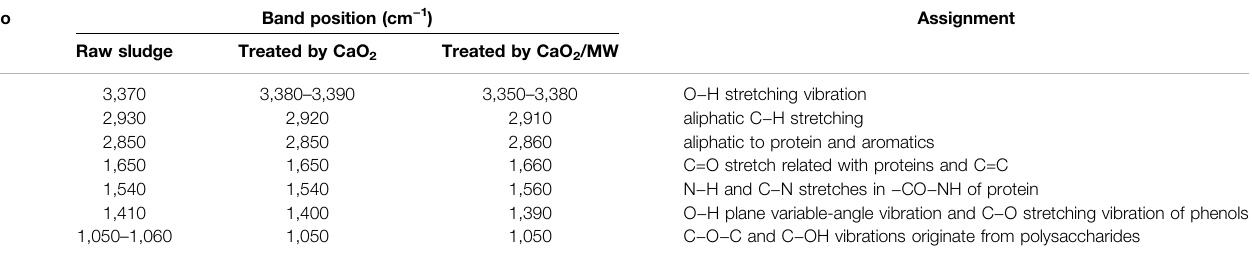
TABLE 4 | Main shifts of raw sludge and sludge treated by CaO 2 and CaO 2 /MW. No